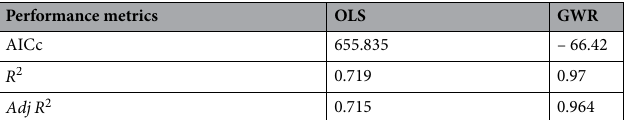
Table 6. Performance comparison OLS and GWR models in terms of three performance metrics: AICc, R 2 , and Adjusted R 2 .